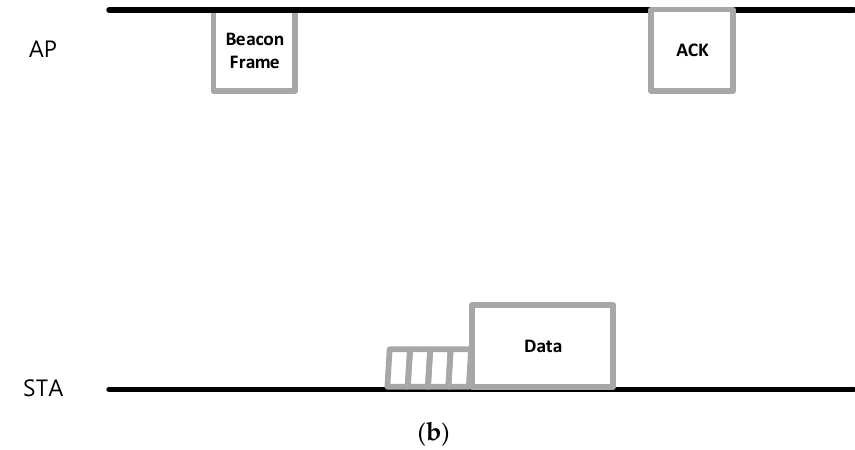
Figure 4. IEEE 802.11 procedures for transmitting its data frame to an unassociated AP: ( a ) Conventional IEEE 802.11 procedure; ( b ) IEEE 802.11p procedure.